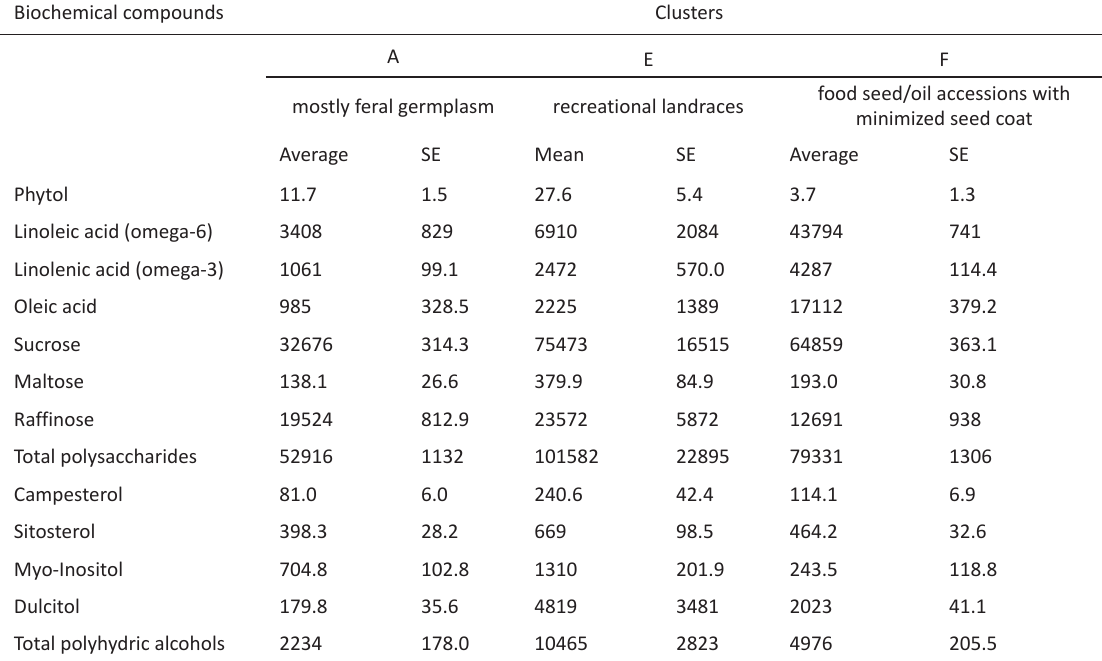
Table 3. Amounts of functional food ingredients, prebiotics and phytosterols in seeds of hemp ( Cannabis spp.) accessions (ppm in dry matter ) united in cluster A and the distanced clusters E and F Biochemical